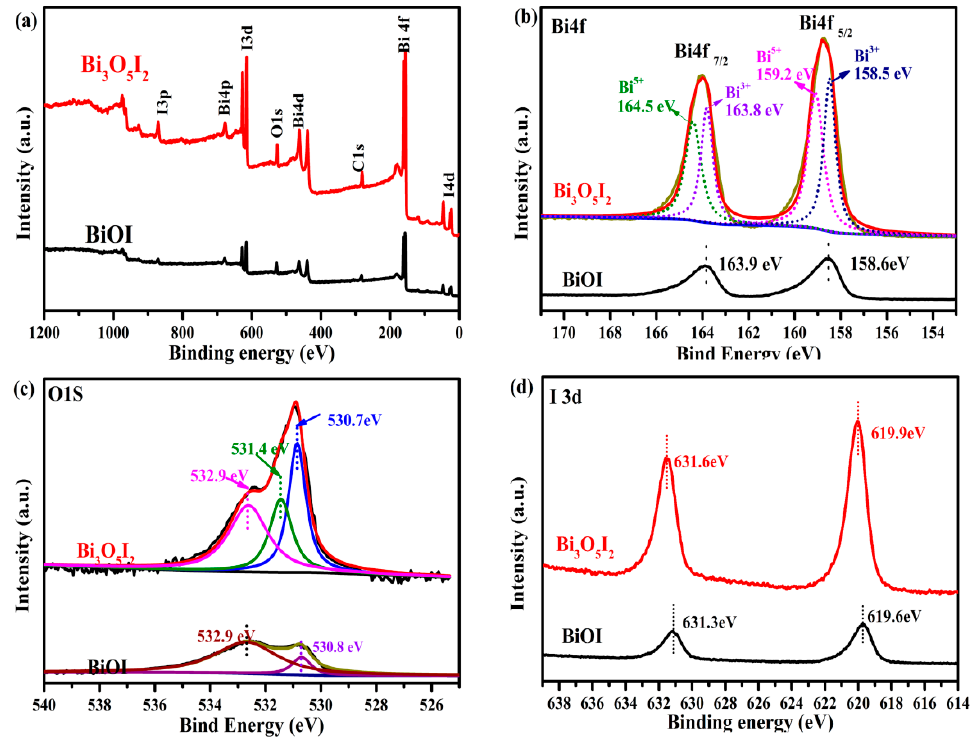
Figure 5. XPS spectra of Bi 3 O 5 I 2 and BiOI: ( a ) Survey, ( b ) Bi 4f, ( c ) O 1s, ( d ) I 3d.